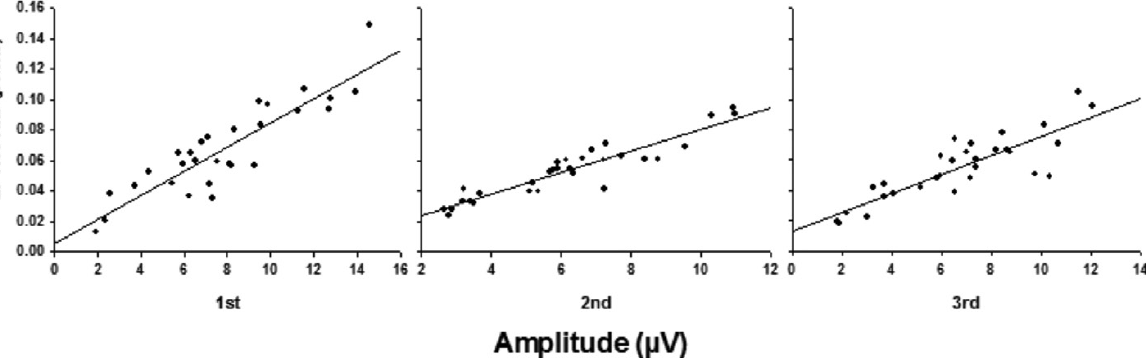
Figure 4 - Scatter plots of data from tests with the first, second and third stimuli show the positive relation between P2 rise rate and amplitude under drug-free condition. The solid lines indicate the least squares regression lines (see details in the